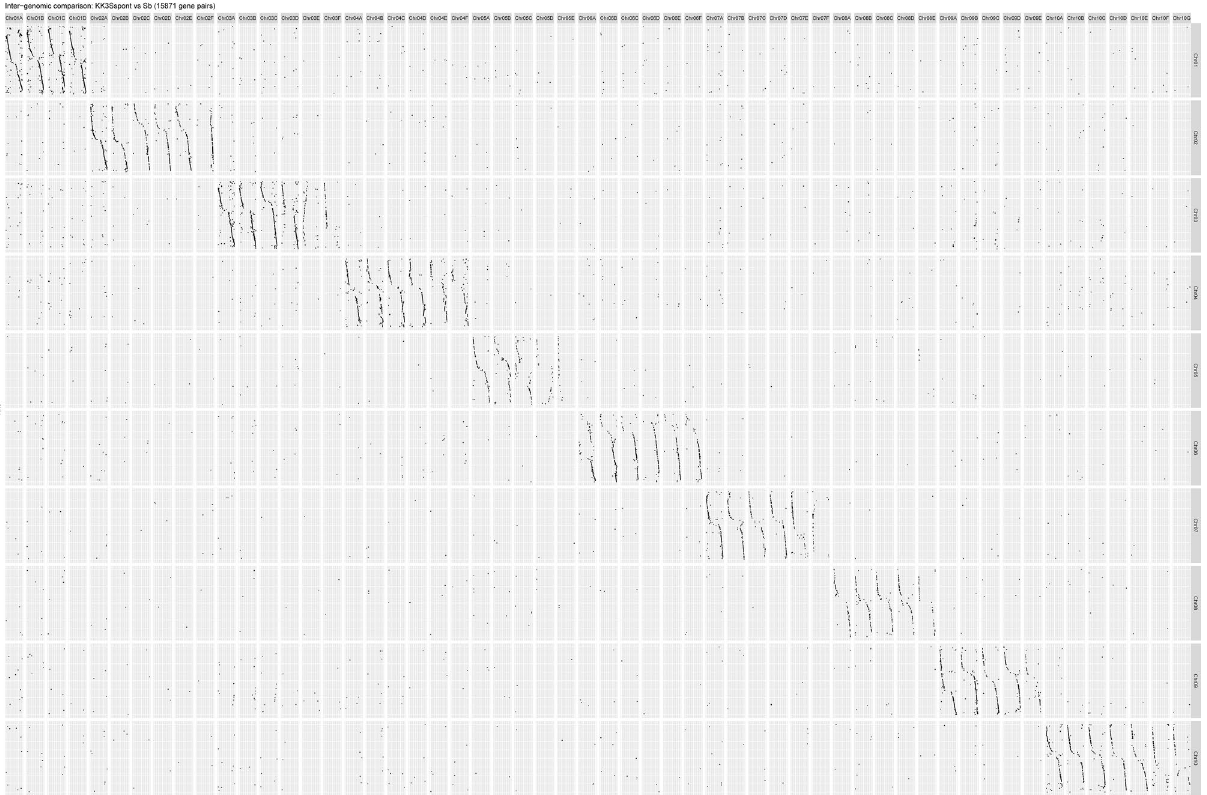
Figure 1. Gene synteny between the KK3 pseudo chromosomes and Sorghum bicolor . Dot plot showing the relative location of each homologous gene between the KK3 chromosomes and Sorghum bicolor chromosomes. Chromosomes are scaled to maintain relative distance between genes, but remove size differences between chromosomes. The chromosomes of KK3 are numbered according to which S. bicolor chromosome they represent and assigned a letter to differentiate between